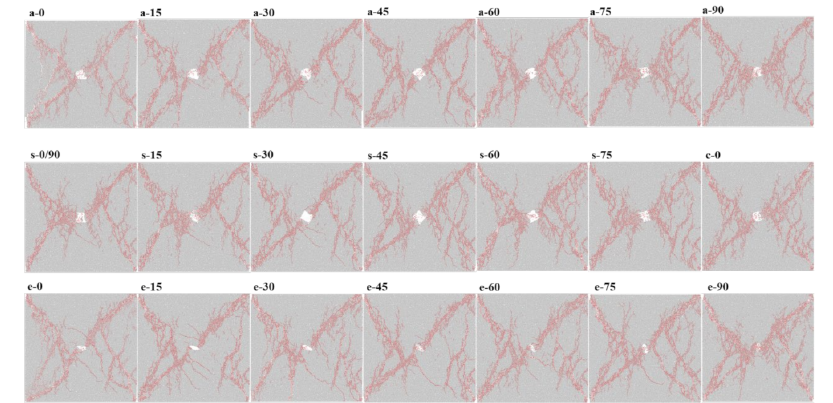
Figure 10. Ultimate failure images of pre-holed specimens under coupled biaxial loading and unloading